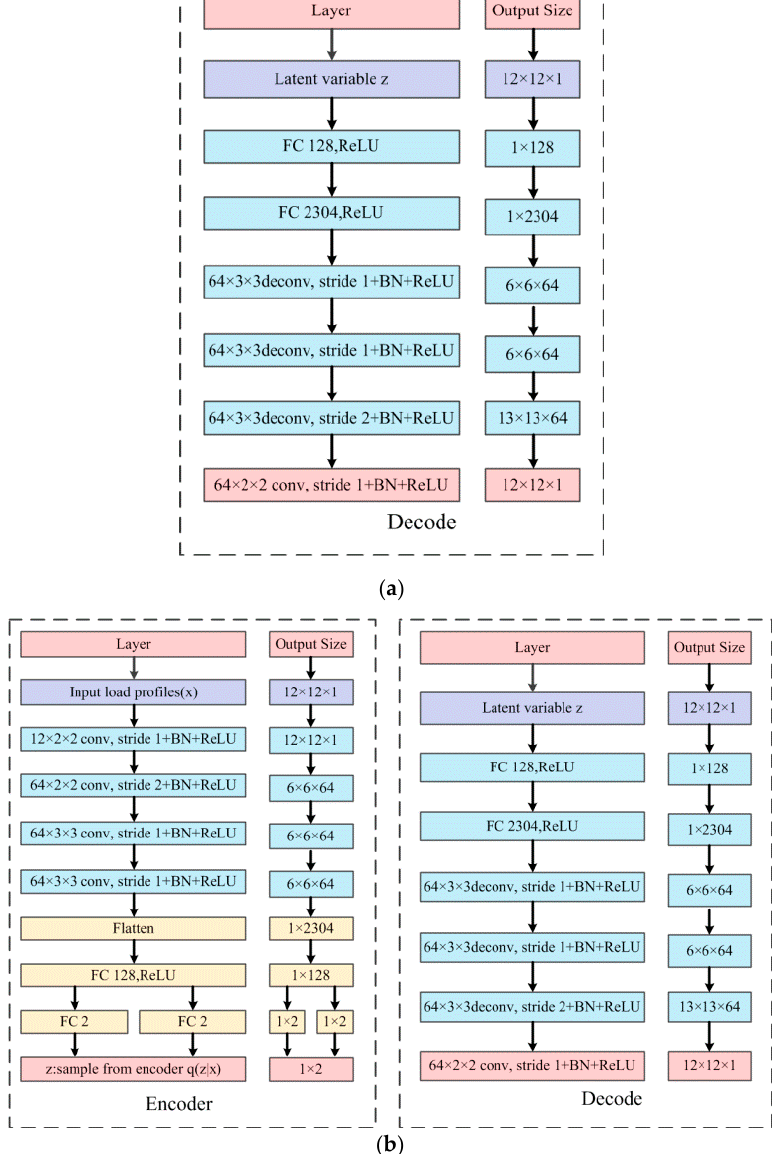
Figure 3. Architecture and parameters of auto-encoder network. ( a ) Architecture and parameters of encoder; and, ( b ) Architecture and parameters of decoder.